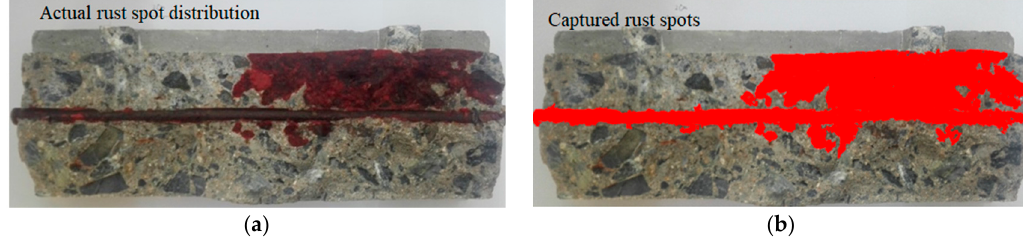
Figure 11. Corrosion analysis of corroded reinforced concrete. ( a ) Actual rust spot distribution; ( b ) Captured rust spots.